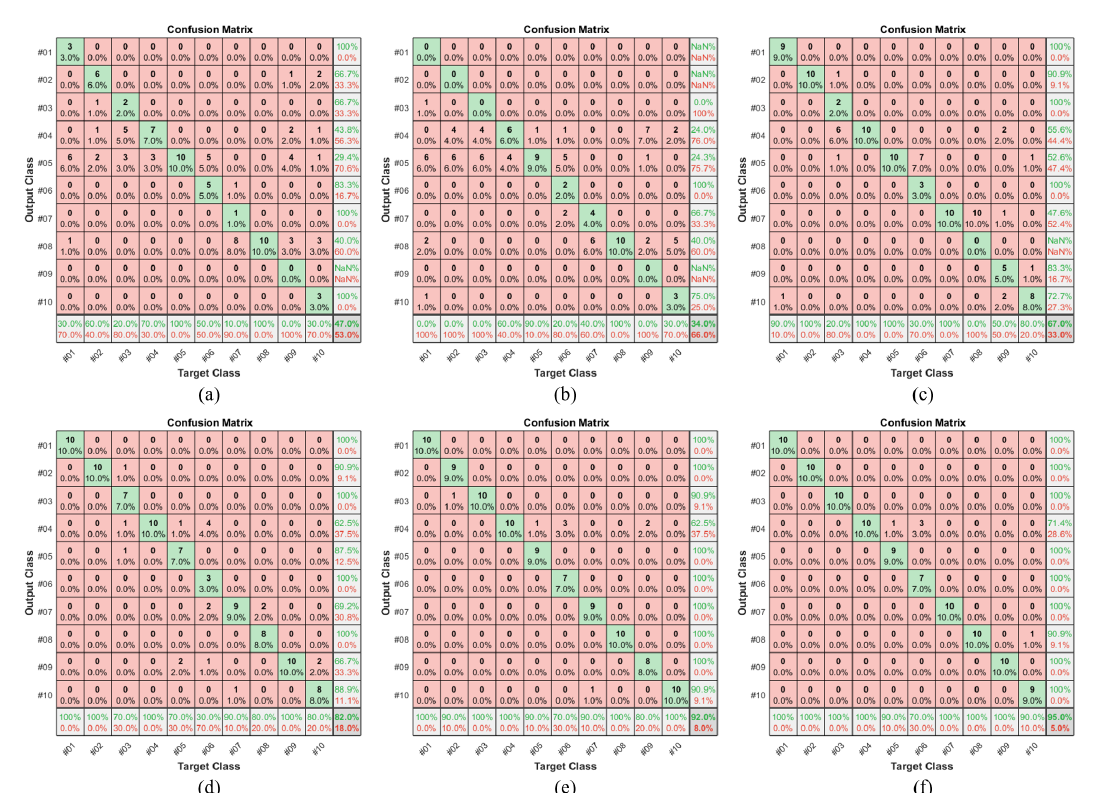
Figure 8. Comparison of confusion matrices: ( a ) Traditional Method #1; ( b ) Traditional Method #2; ( c ) RGB PSNR + Lab PSNR with no geometric transformation; ( d ) RGB PSNR + Lab PSNR with flipping;